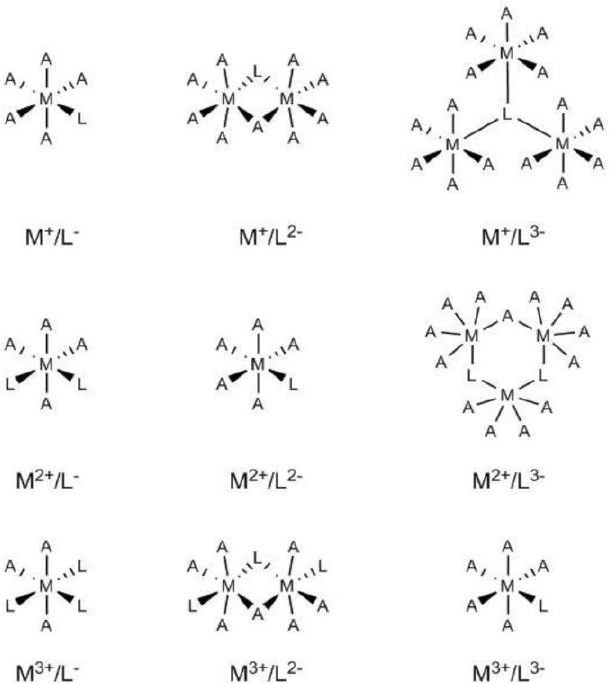
Figure 1. Schematic representation of the structures employed as initial geometries for the different M x L y · n H 2 O systems. The capital A represents the explicit water molecules added to complete the coordination sphere of the metal centres.